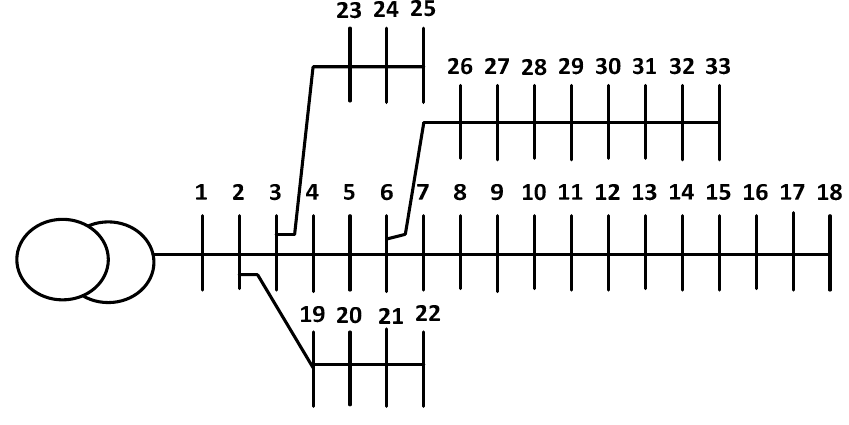
Figure 8. IEEE 33 radial distribution system.